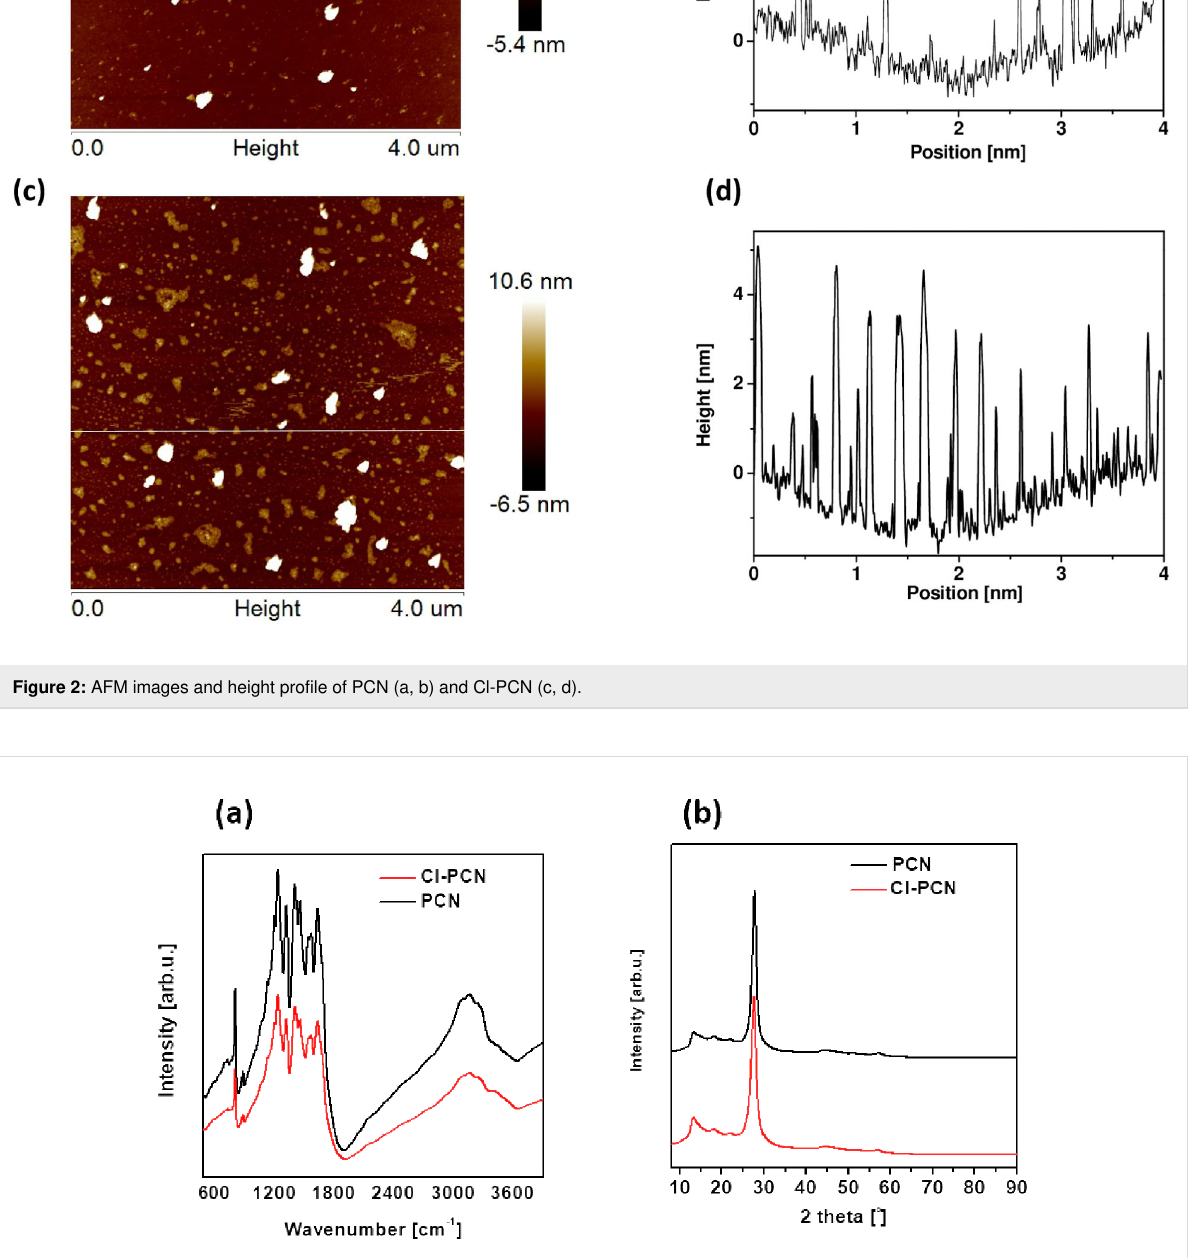
Figure 3: (a) FTIR spectra and (b) XRD patterns of PCN and